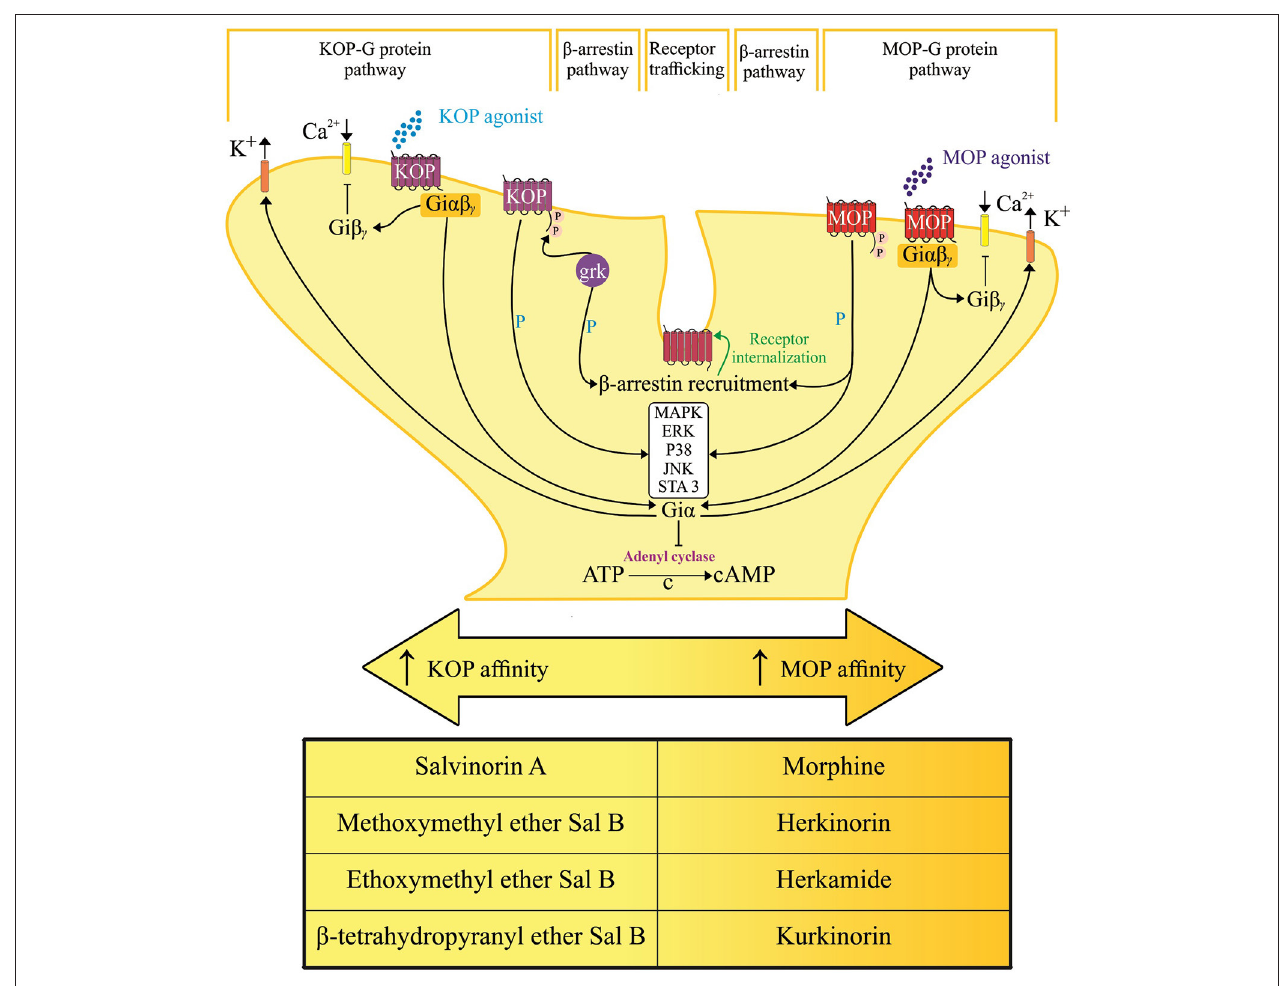
FIGURE 2 | Hypothetical representation of signal transduction and trafficking of mu [ µ ] and kappa [ κ ] opioid receptor. Converging downstream pathways are activated by salvinorin A and its analogs with selective action and varying affinity on their respective opioid receptor subtypes. Arrows, activation; T lines, blockade of function; βγ , G protein β - γ subunit; cAMP, cyclic adenosine monophosphate; ERK, extracellular signal-regulated kinase; JNK, c-jun N-terminal kinase; MAPK, mitogen-activated protein kinases; GRK-3, G protein-receptor kinase 3; P, phosphorylation; C → , cyclization of adenosine triphosphate (ATP) into cyclic adenosine monophosphate (cAMP) through the cleavage of